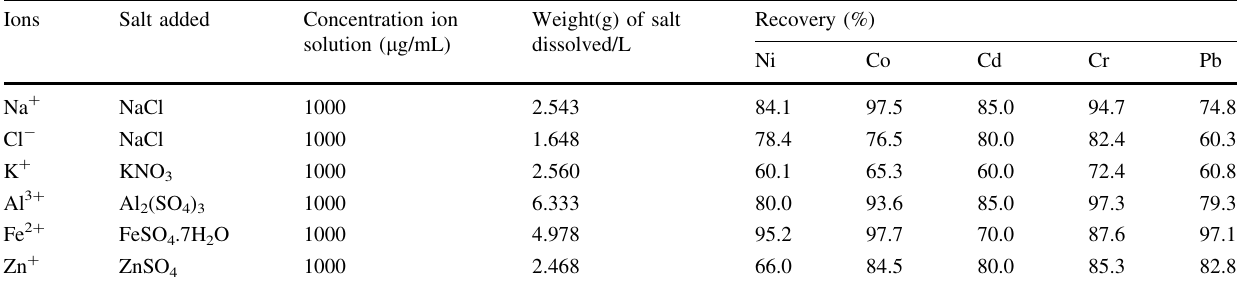
Table 1 Effect of interfering ion on co-precipitation procedure Ions